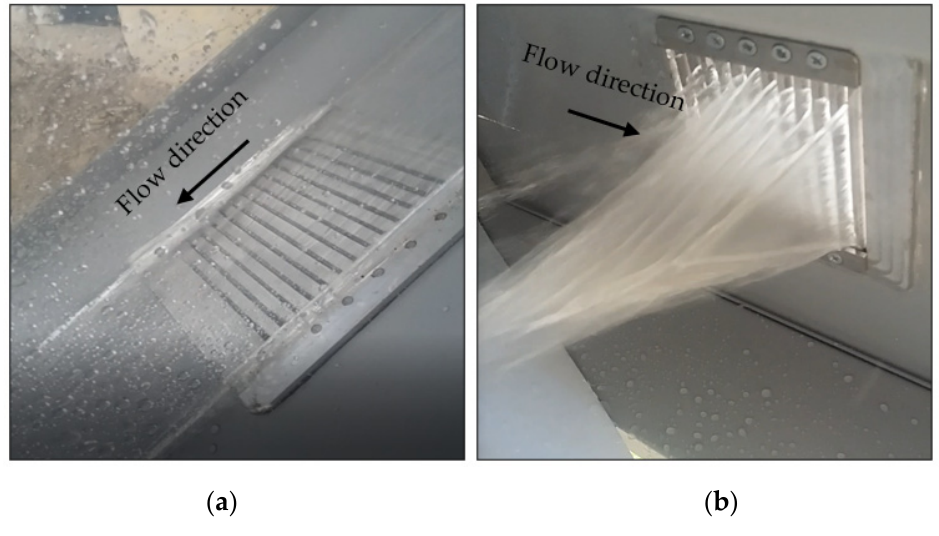
Figure 5. ( a ) Flow over Coanda screen; ( b ) diverted flow.